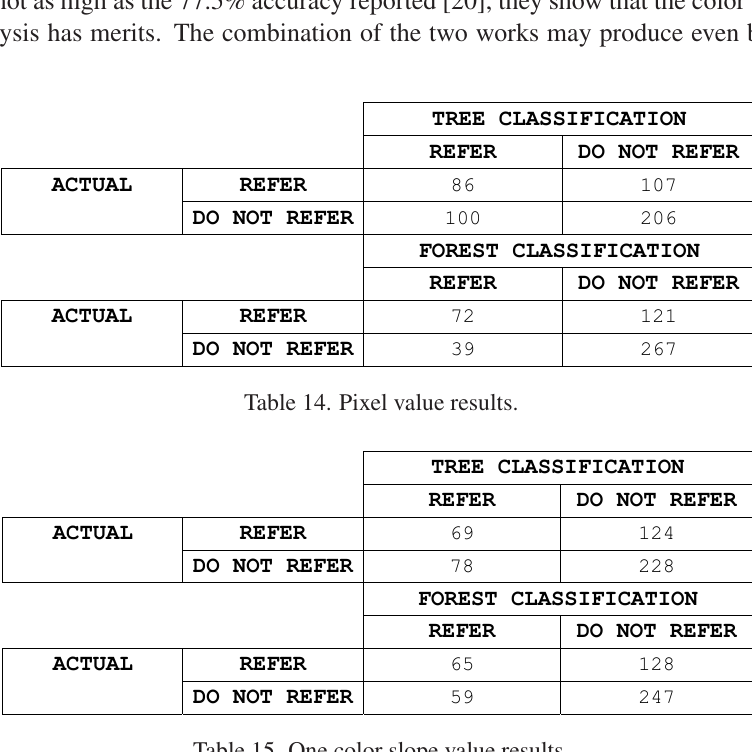
Table 15. One color slope value results.